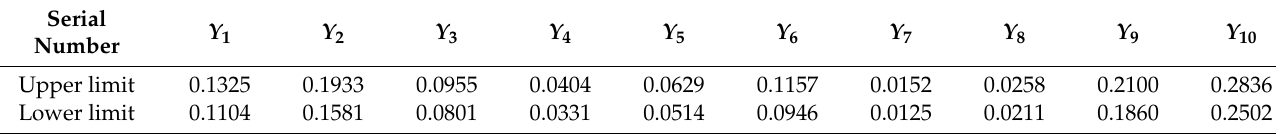
Figure 11. Distributions of variable and fixed points (blue: fixed points; red: variable points). Table 5. Variation ranges of variables.